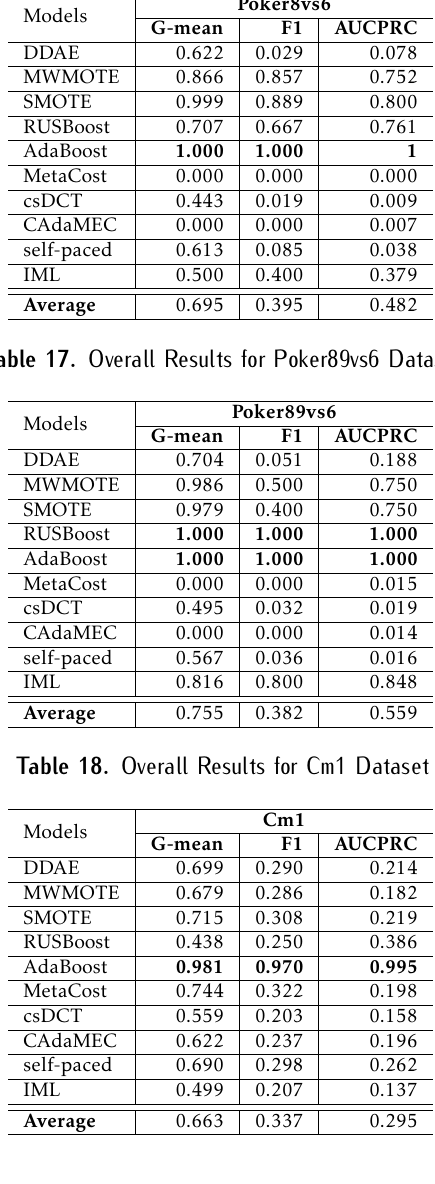
Table 12. Overall Results for MGC Dataset Models